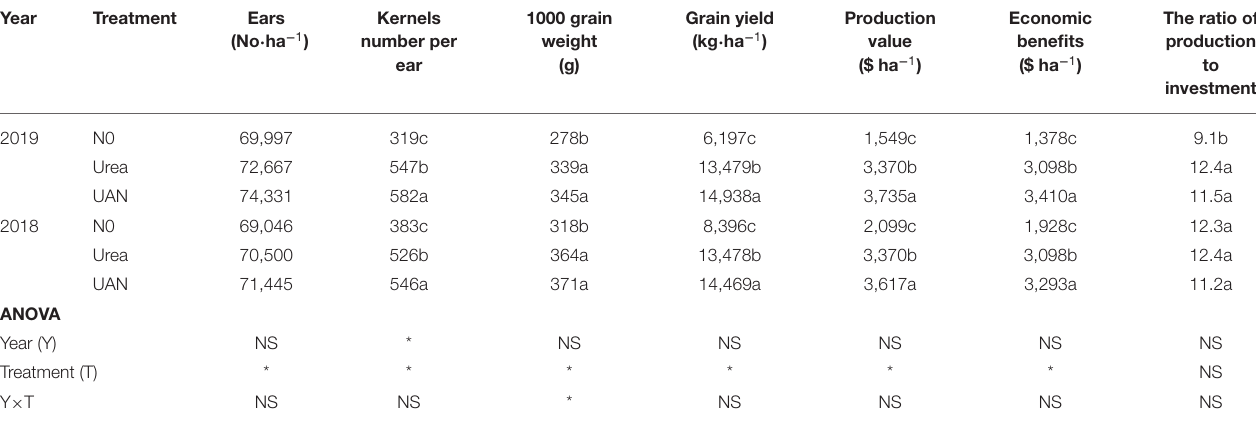
TABLE 1 | Effects of nitrogen fertilizer types on grain yield and production values of summer maize.